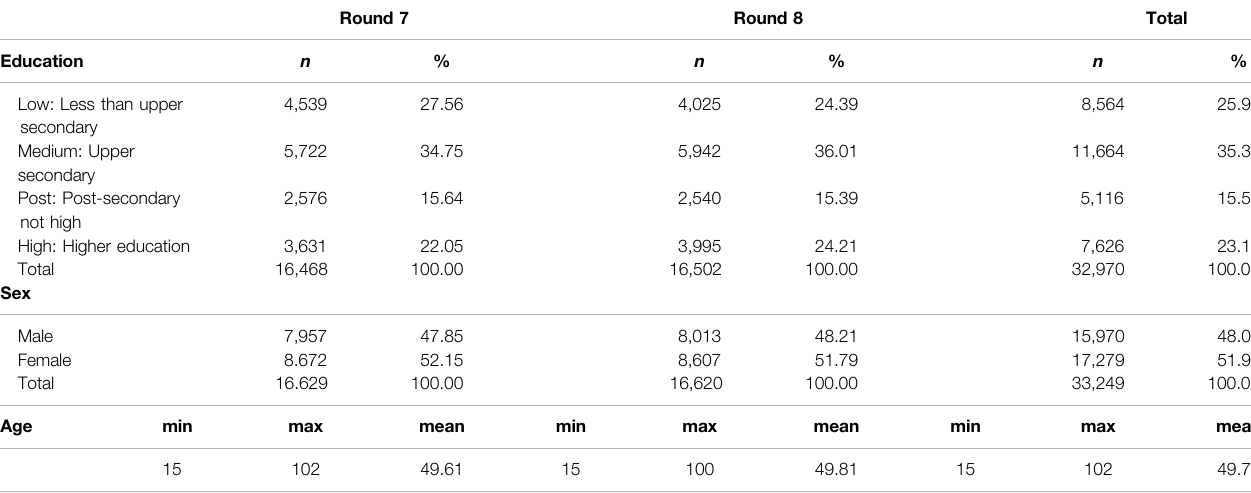
TABLE 2 | Descriptive statistics for control variables.